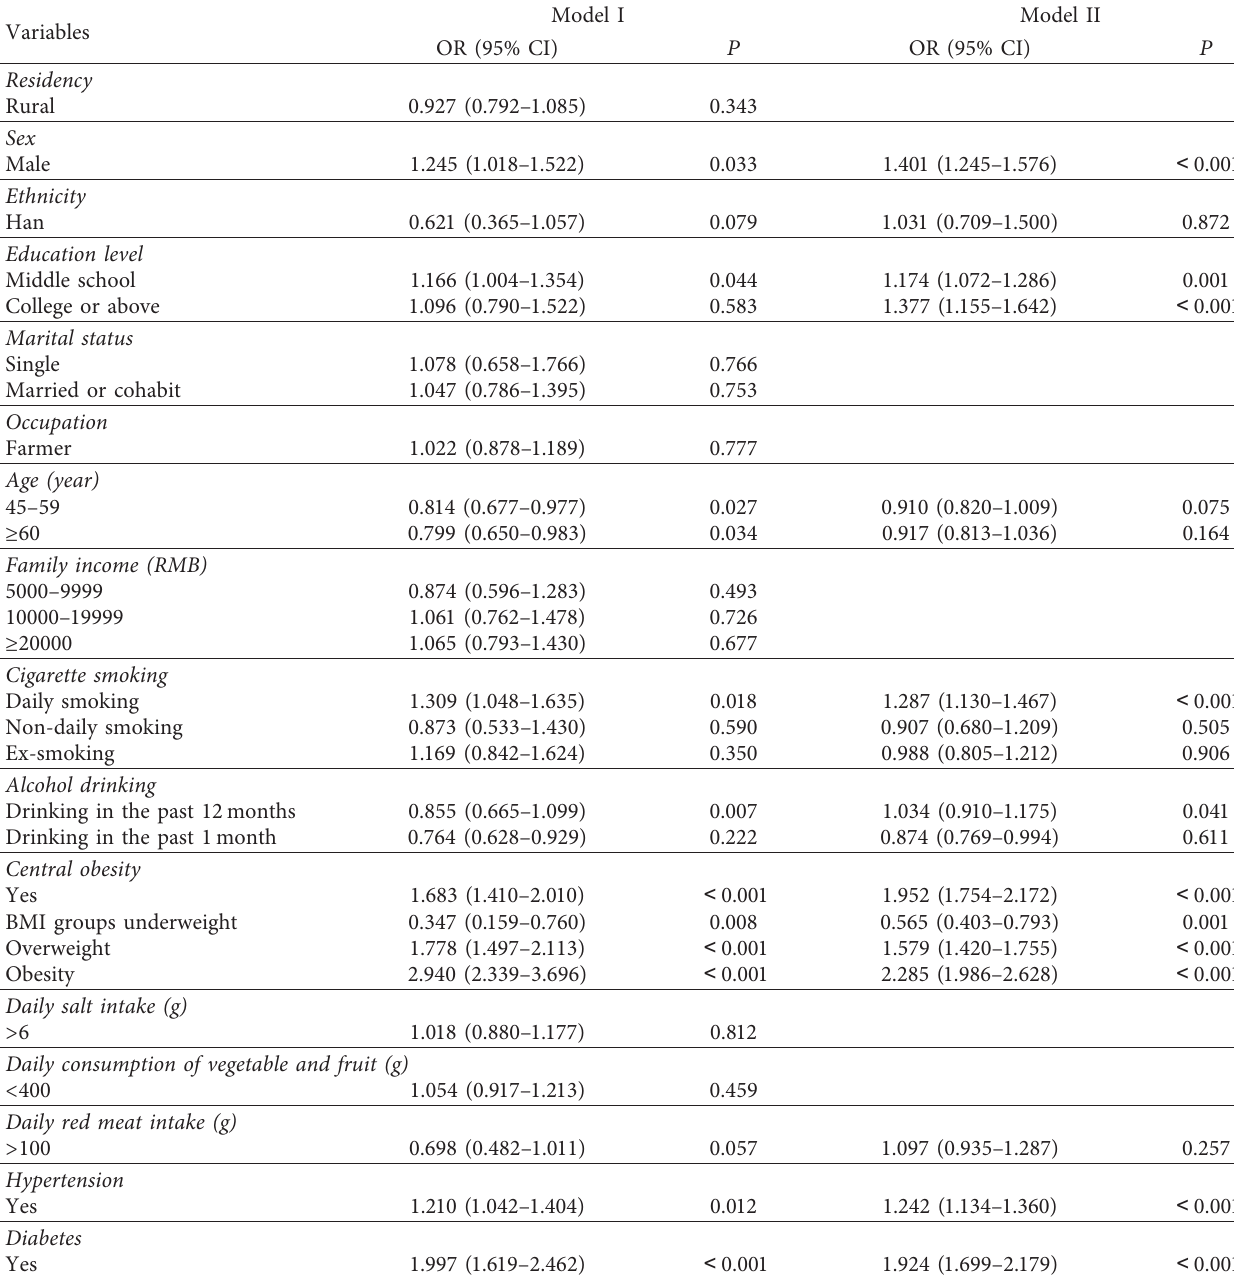
Table 5: Logistic regression analysis on risk factors of dyslipidemia among adults from northwest